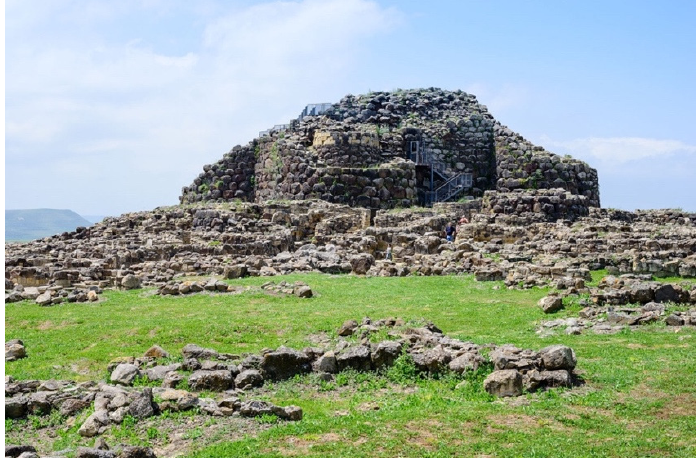
Figure 3. Su Nuraxi di Barumini (‘Nuraghe Su Nuraxi’ by Norbert Nagel 2013/Wikimedia Commons is released under CC BY-SA 3.0).